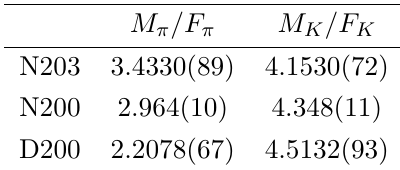
Table 2. Pion and kaon decay constants determined in ref.